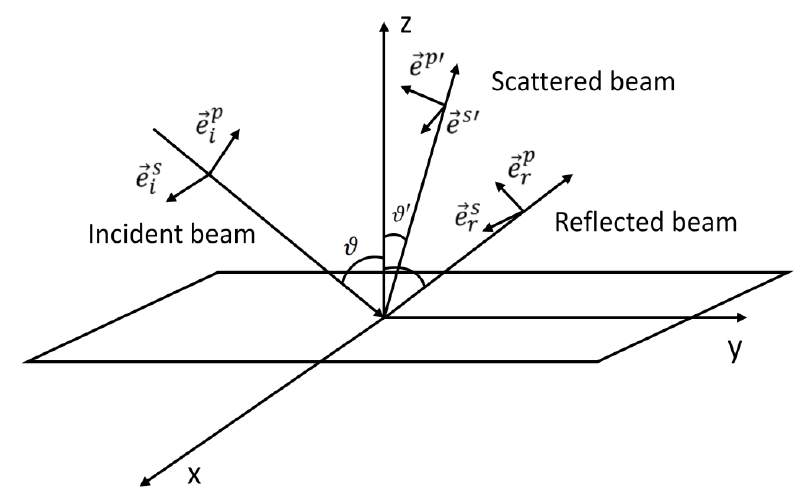
Figure 6. Scheme of the geometrical layout and definition of the coordinates. All symbols have usual meanings as described in the text. The components of the scattered field experiencing a reflection from the surface ( 𝐸⃗ 𝑟 𝑠′ and 𝐸⃗ 𝑟 𝑝′ ) are not included in the scheme for simplicity.